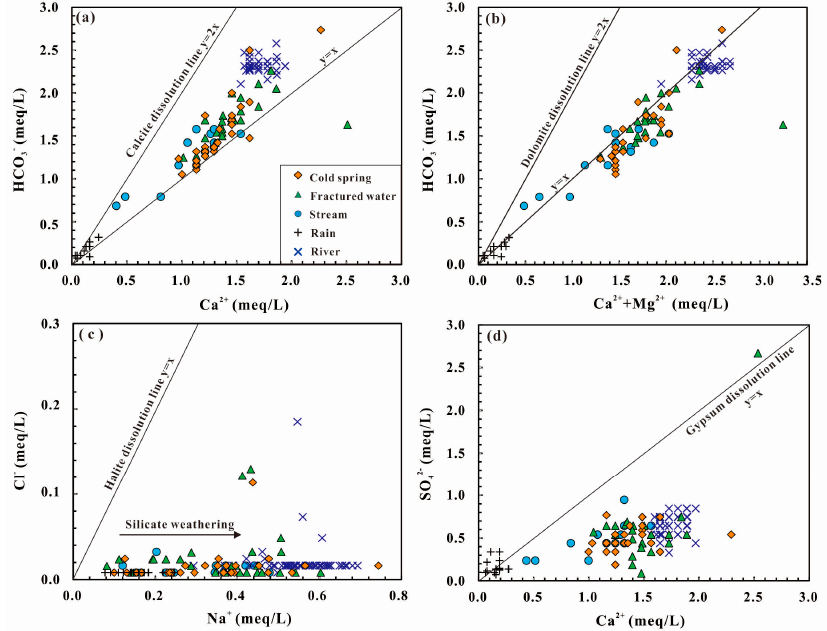
Figure 6. Distributions of ionic ratios in water samples, ( a ) HCO 3 − versus Ca 2+ ; ( b ) HCO 3 − versus Ca